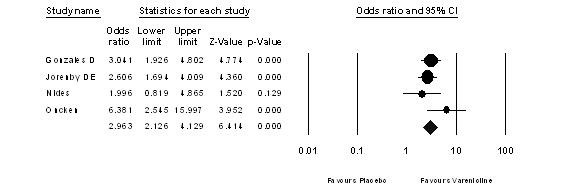
Random Effects Meta-Analysis. Varenicline vs. Placebo at 12 months. I2 = 20.5%.